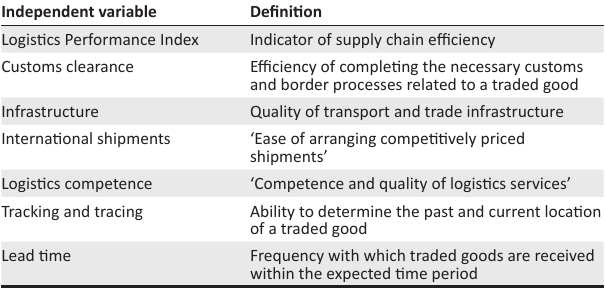
TABLE 1: Independent variables utilised in the econometric analysis. Independent variable